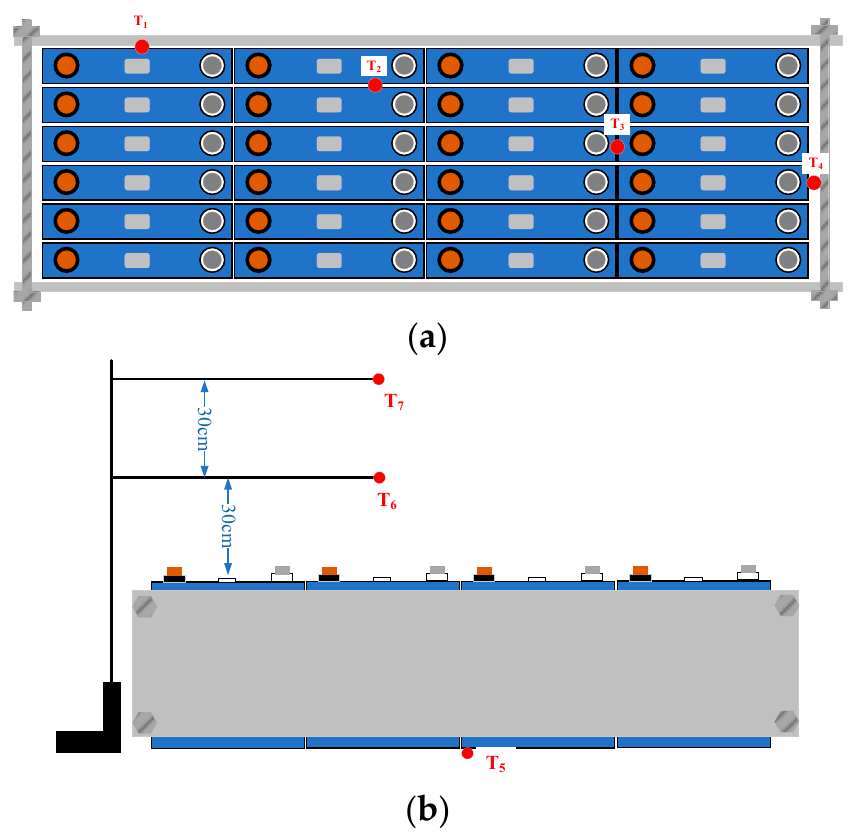
Figure 1. Schematic diagram of the LFP batteries and thermocouple arrangements: ( a ) vertical view; ( b ) side view.